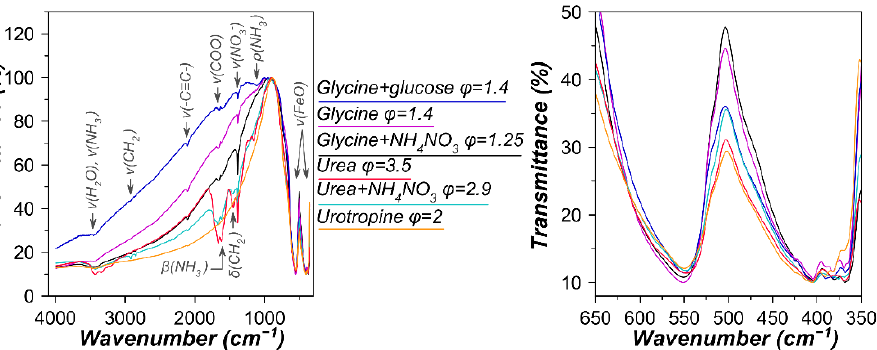
Figure 3. XRD patterns of synthesized materials by ( a ) glycine-nitrate; ( b ) urea-nitrate; and ( c ) urotropine-nitrate combustion at the various fuel-to- oxidizer ratios (φ) (where o -CeFeO 3 – ortho- rhombic perovskite CeFeO 3 (JCPDS card no. 00-022-0166); c-CeO 2 – cubic CeO 2 (JCPDS card no. 01-